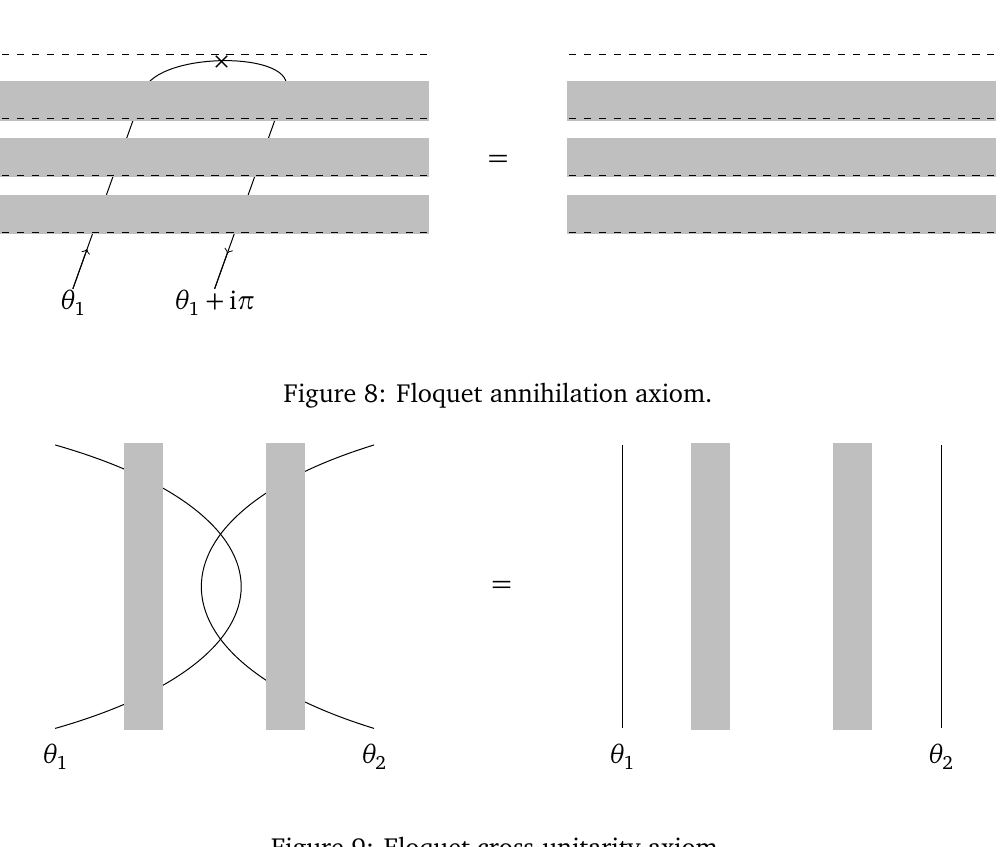
Figure 9: Floquet cross-unitarity